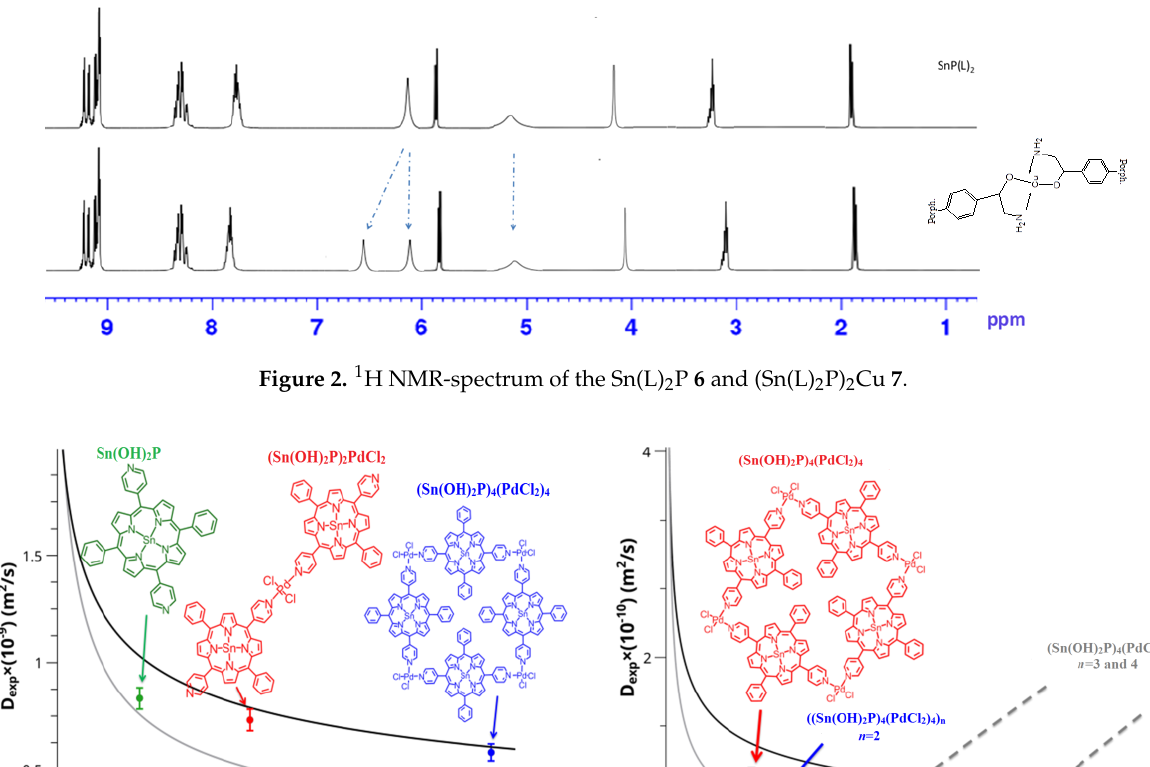
Figure 2. 1 H NMR − spectrum of the Sn(L) 2 P 6 and (Sn(L) 2 P) 2 Cu 7.